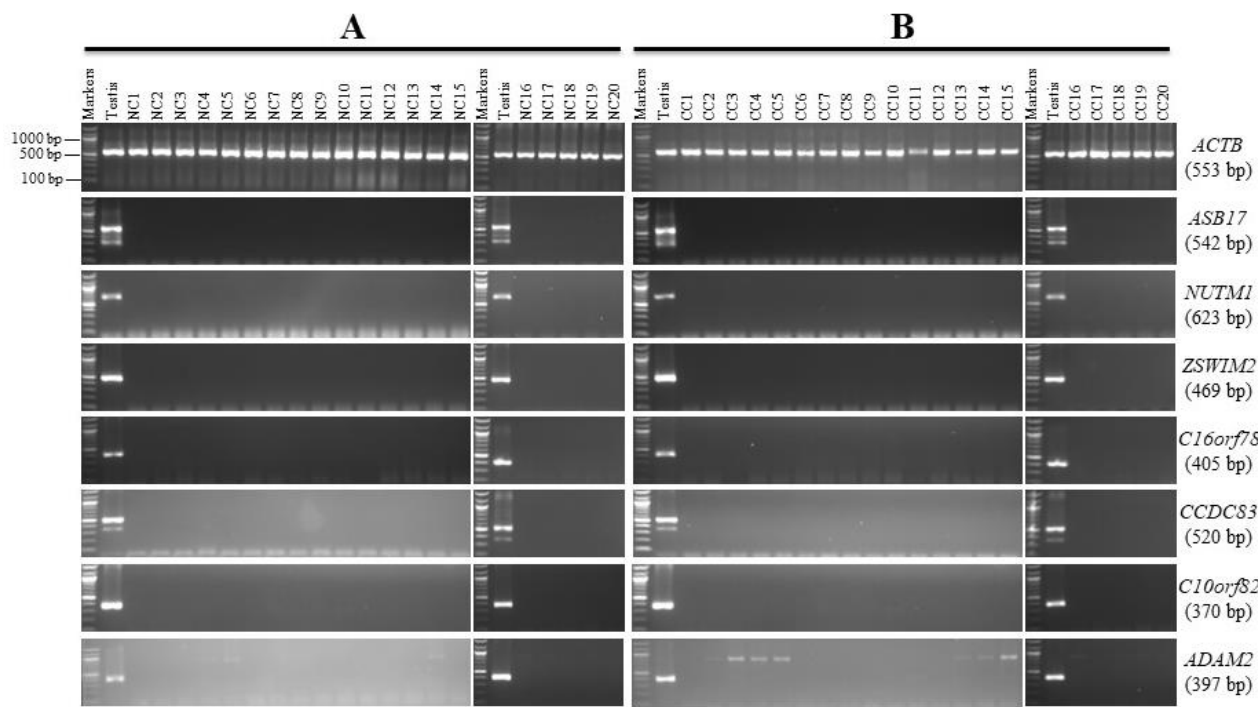
Figure 2. RT-PCR expression profiles for the meiotic restricted genes in matching normal colon (NC) and colon cancer (CC) tissues. Agarose gels display the RT-PCR analysis for the ASB17, NUTM1, ZSWIM2, C16orf78, CCDC83, C10orf82, and ADAM2 genes. cDNAs were synthesized from the total RNA from 20 NC tissues ( A ) and CC tissues ( B ). ACTB expression was used as a positive control for the cDNA samples. Testis cDNA was used to test the primer for each gene. The expected product size of each gene is presented on the right between